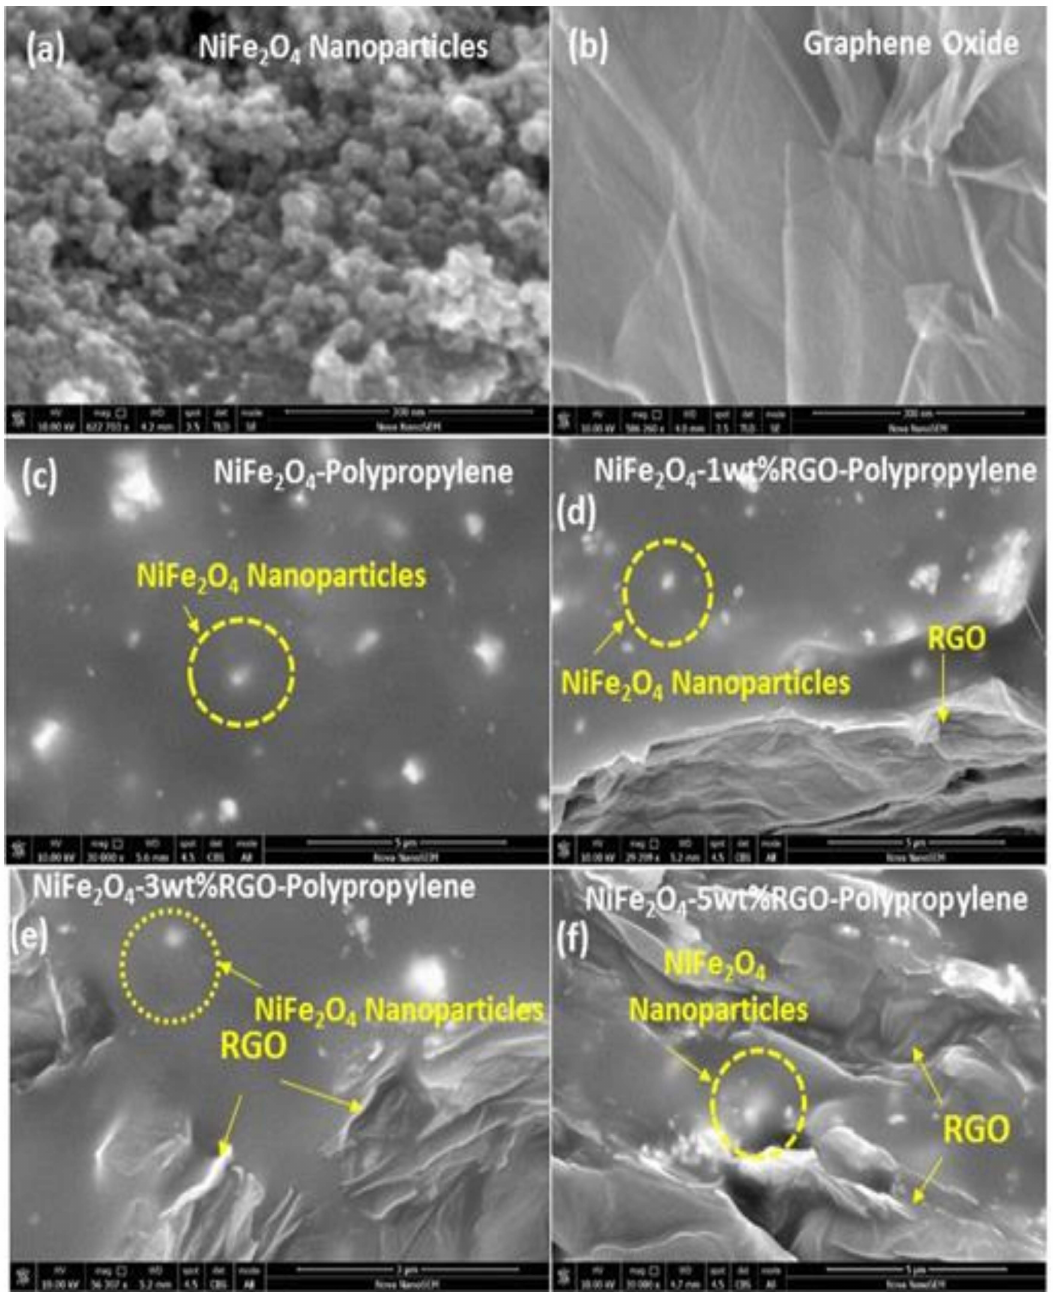
Figure 4. Field emission scanning electron microscopy (FE-SEM) images of ( a ) spinel ferrite NiFe 2 O 4 nanoparticles and ( b ) prepared graphene oxide, and cross sections of ( c ) NiFe 2 O 4 -Polypropylene, ( d ) NiFe 2 O 4 -1wt% RGO-Polypropylene, ( e ) NiFe 2 O 4 -3wt% RGO-Polypropylene, and ( f ) NiFe 2 O 4 -5wt% RGO-Polypropylene